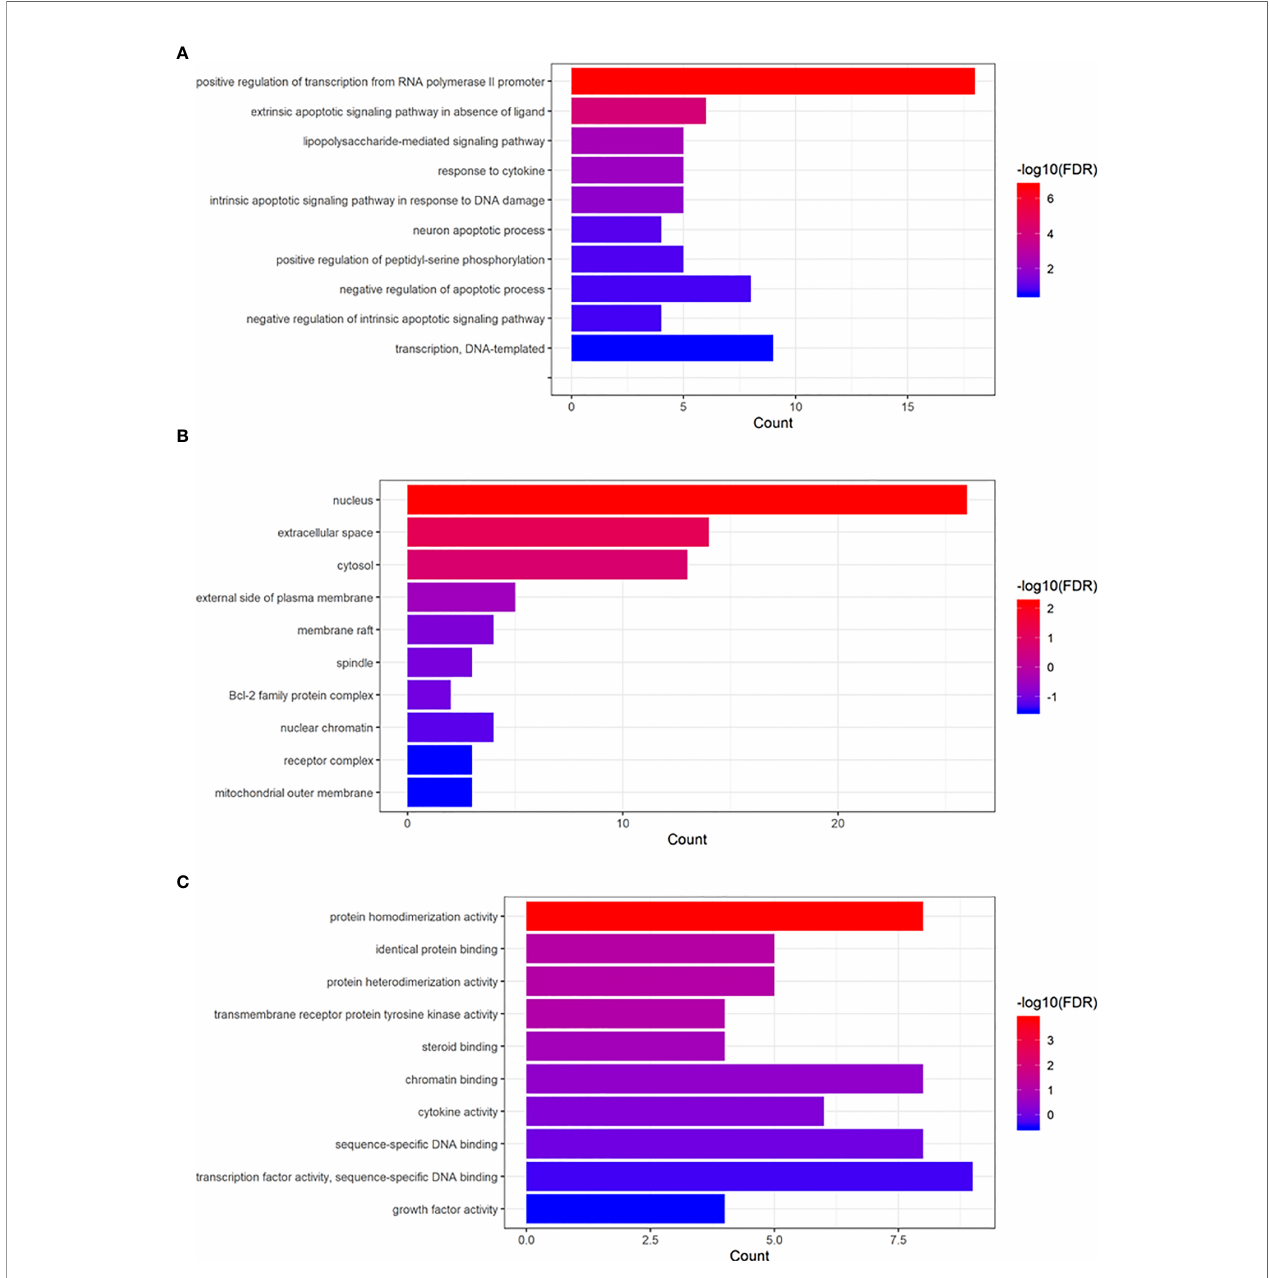
FIGURE 5 | Gene Ontology enrichment analysis of common genes. (A) Biological process, (B) cellular component, (C) molecular